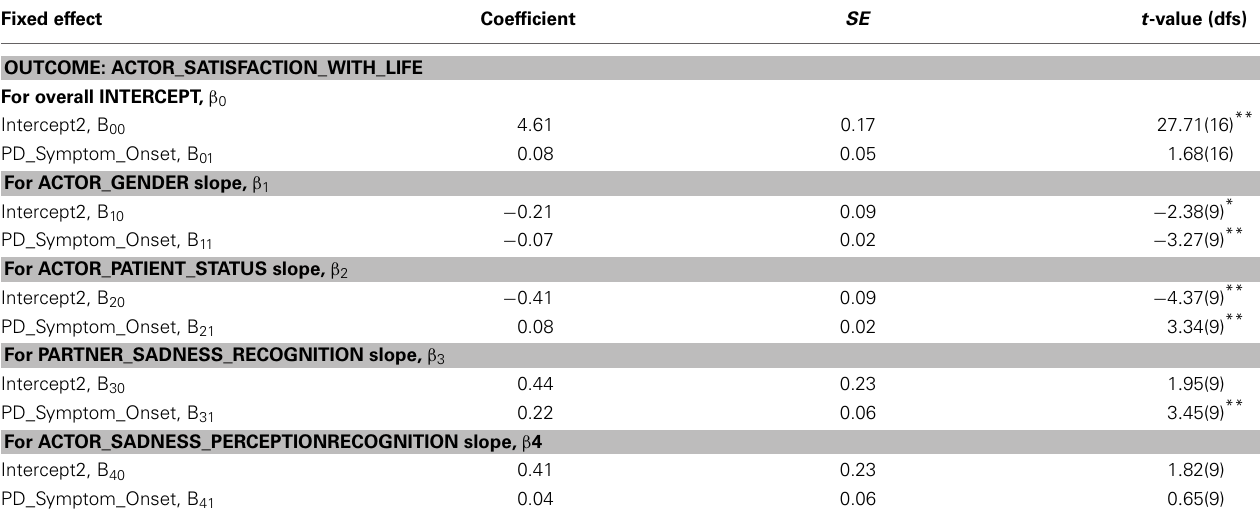
Table 6 | Parameter estimates for the HLM analyses predicting an actor’s hedonic balance and life satisfaction from his/her partner’s proficiency in identifying sadness in Study